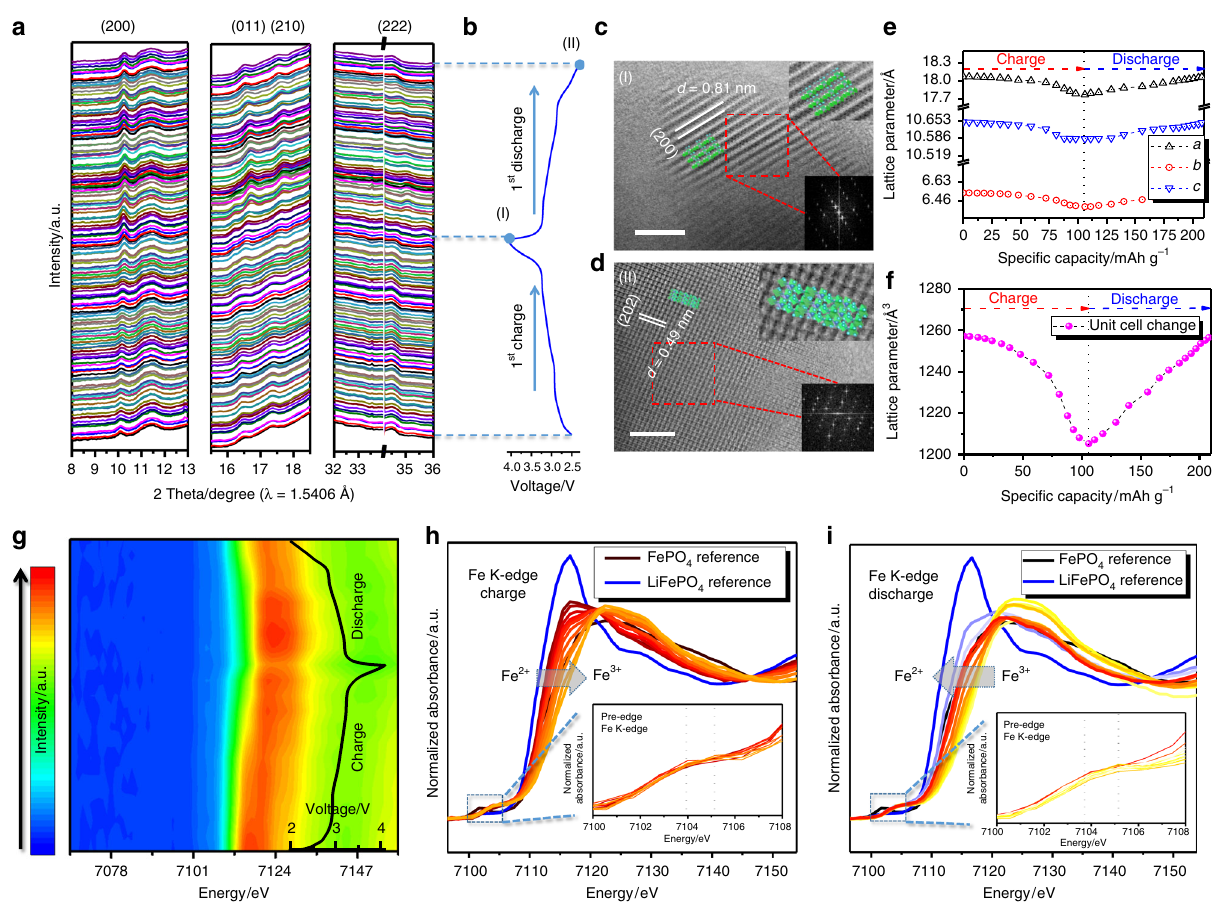
Fig. 4 Sodium-storage mechanism investigations. a In-situ synchrotron-based XRD patterns and b corresponding charge-discharge curves of NFPP-E electrode during the fi rst cycle. c , d HRTEM images of fully charged and fully discharged NFPP-E electrodes. e Variations of a , b , and c lattice parameters during the charge/discharge process. f Volume change details during the charge/discharge process. g In-situ XANES spectra at the Fe K-edge of NFPP-E electrode (2D contour plot) as a function of charge-discharge curve. h Charge process and i discharge process of typical Fe K-edge XANES spectra. The insets in h and i are the corresponding pre-edge spectra. Scale bars: 5 nm ( c ); 5 nm ( d